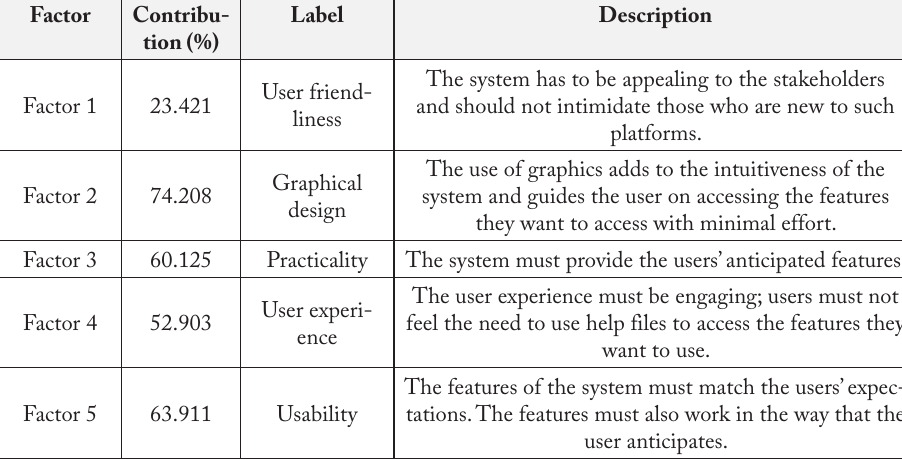
Table 7: Five underlying factors uncovered by PCA